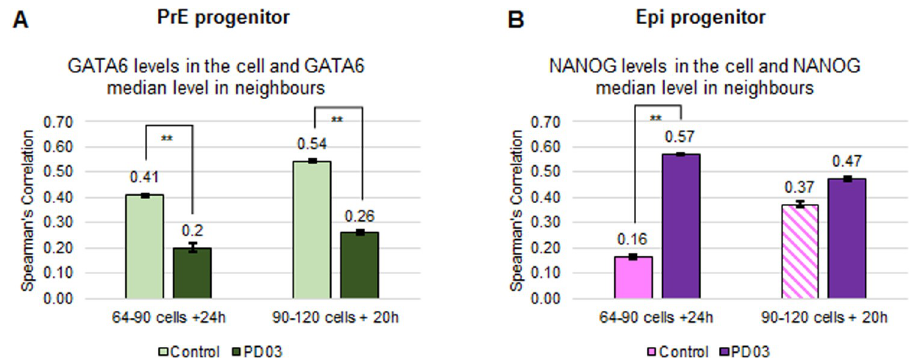
Fig 8. Inhibition of FGF/MAPK signalling inhibits GATA6 clusters and promotes NANOG clusters (data V-VIII). (A-B) Spearman’s correlation coefficients of GATA6 levels of a cell and the median GATA6 levels of its neighbours in PrE progenitor cells (A) or NANOG levels of a cell and the median levels of its neighbours in Epi progenitor cells (B) in control (light green or magenta, respectively; data V and VI) and PD03 treated embryos for 24 h or 20 h (dark green or magenta, respectively; data VII and VIII). The error bars represent the standard errors calculated by bootstrap sampling the experimental data 100 times The Mann-Whitney test with Bonferroni correction for the comparison with the null model results in statistically significant differences in all cases ( �� : p < 0.01; not shown in the figure). Striped boxes indicate those populations composed of less than 108 cells. In those cases, no statistical analysis was performed. Details on the number of embryos and cells analysed are in S1 and S2 Tables 1. See also S11 and S12